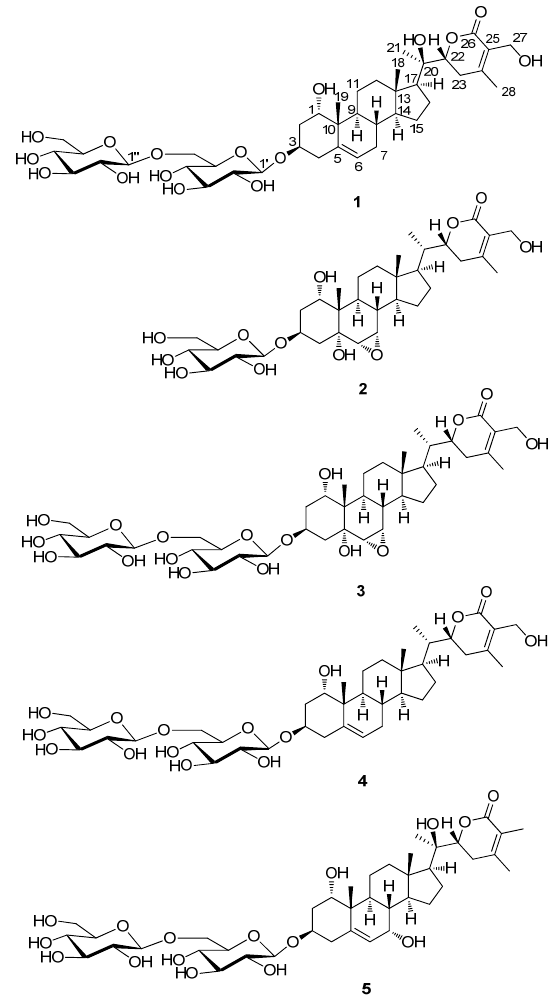
Figure 3. Chemical structures of compounds 1 – 5 .